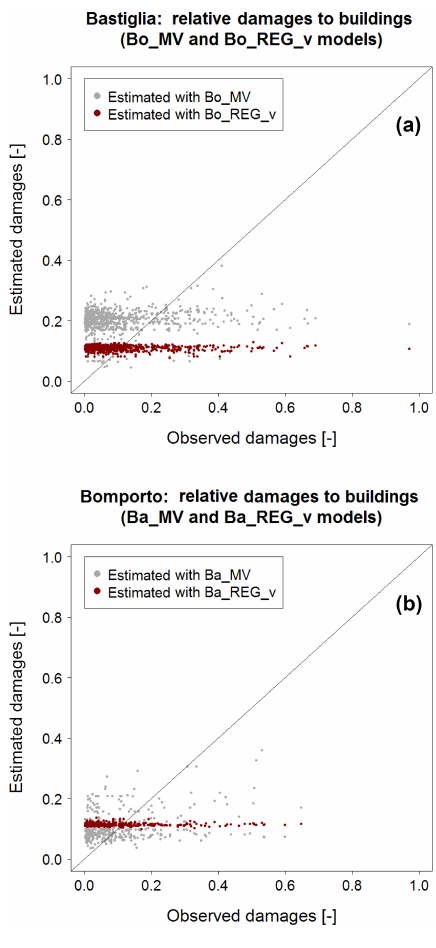
Figure C1. (a) Bastiglia relative damages to buildings estimated with Bo_REG v (red dots) and Bo_MV (grey dots); (b) Bomporto relative damages to buildings estimated with Ba_REG v (red dots) and Ba_MV (grey dots).